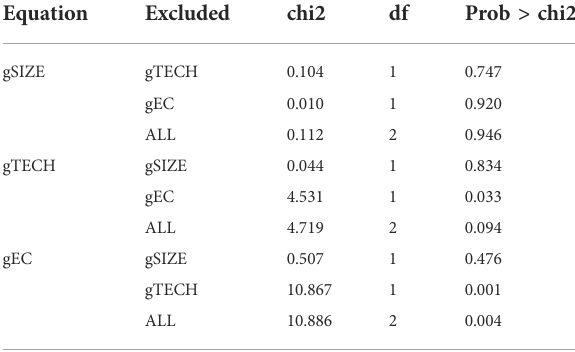
TABLE 5 Granger causality test results.